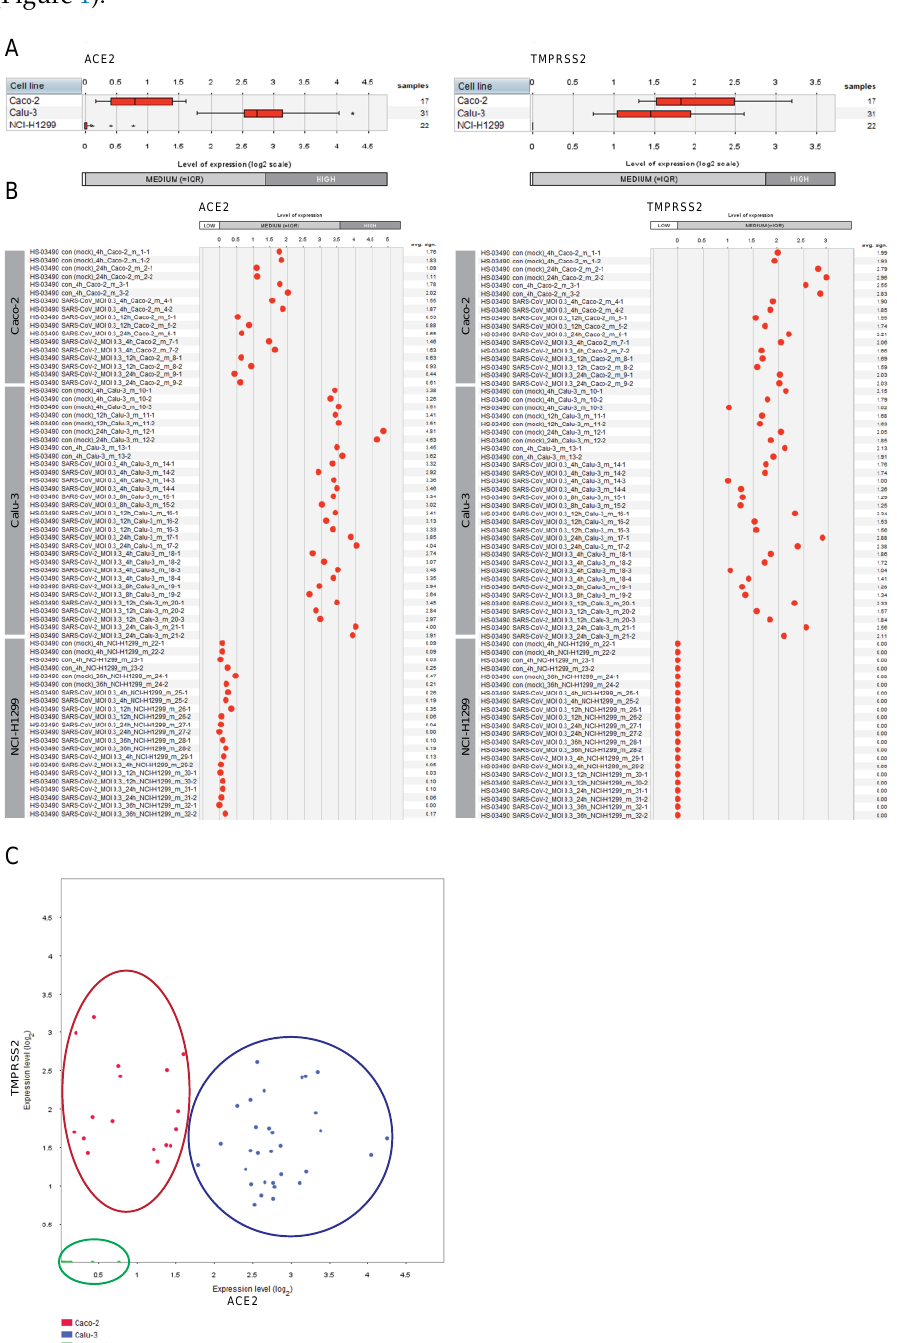
Figure 1. Expression patterns of ACE2 and TMPRSS2 across lung and colon cell lines. GENEVESTIGATOR-based analysis was performed to extract the expression levels of the genes ACE2 and TMPRSS2 from mRNA sequencing (mRNASeq) data (GSE148729) across Caco-2, Calu-3, and NCI-H1299 cells.